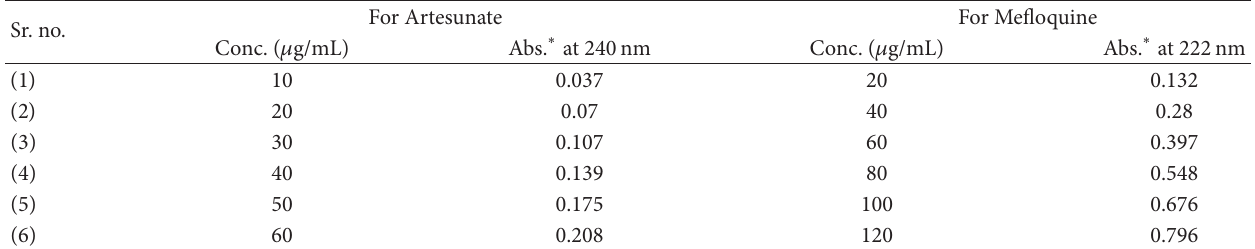
T 1: Standard calibration table for ART and MEF.